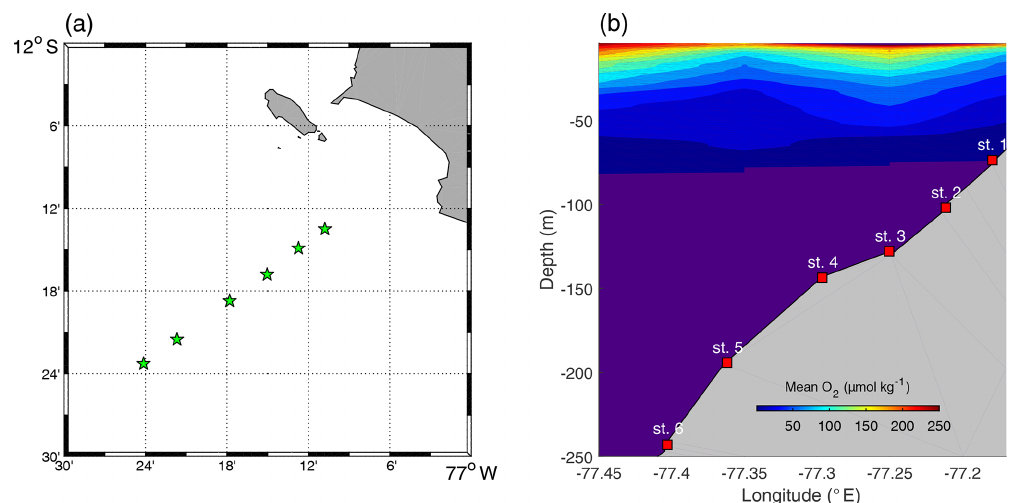
Figure 1. (a) Distribution of sampling stations. (b) Mean oxygen plot (the O 2 values were averaged over 1m depth and 0.1 ◦ longitude intervals). The indigo colour represents values below 1µmolkg − 1